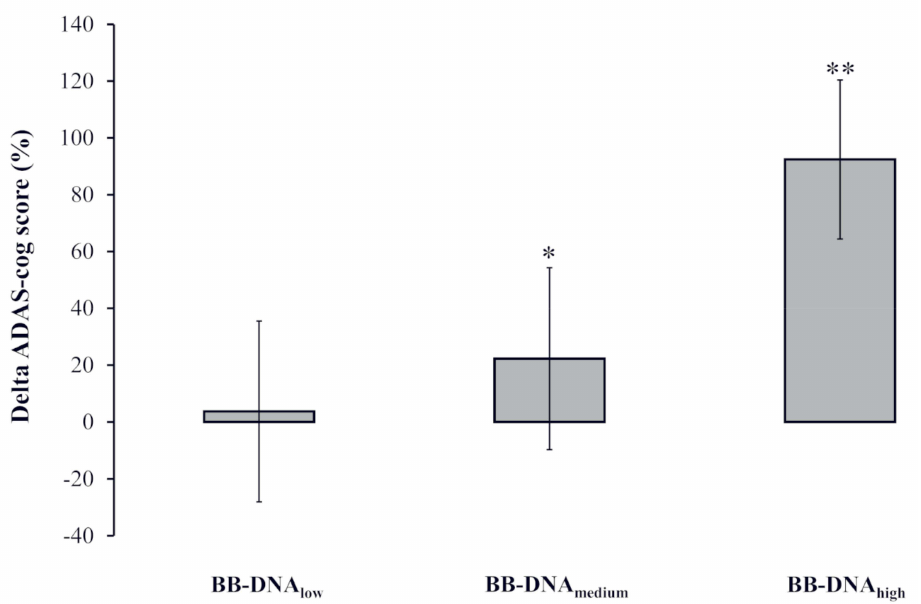
Figure 3. The change in the ADAS-cog score during the two-year follow-up in Alzheimer’s disease (AD) patients in accordance with blood bacterial DNA (BB-DNA) tertiles. Higher values of BB-DNA were associated with a worse cognitive decline after the two-year follow-up. ANCOVA analysis adjusted for age, sex, education, and IADL was applied. ** p < 0.001 as compared to BB-DNA low ; * p < 0.05 as compared to BB-DNA high